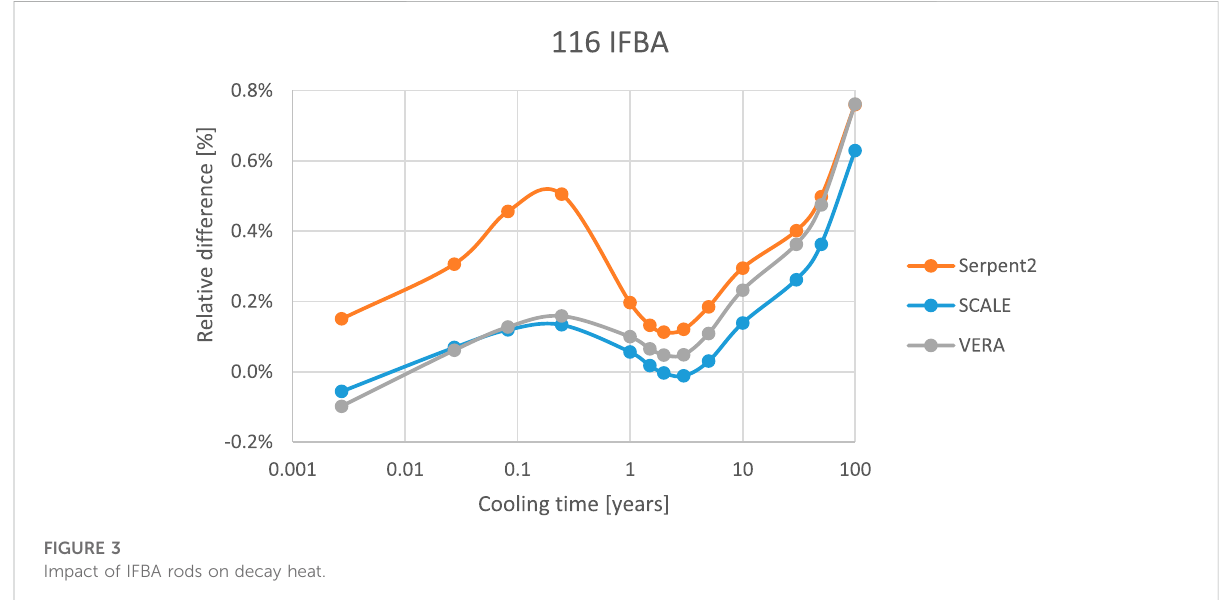
Impact of IFBA rods on decay heat.